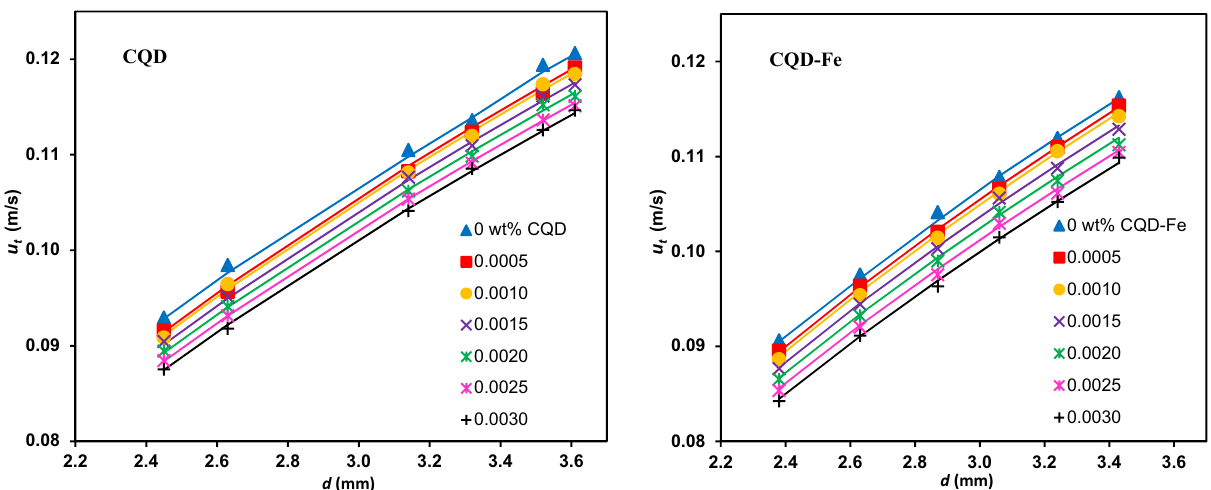
Figure 7. Comparison of the terminal velocity data with the Grace model (continuous lines) for different concentration of